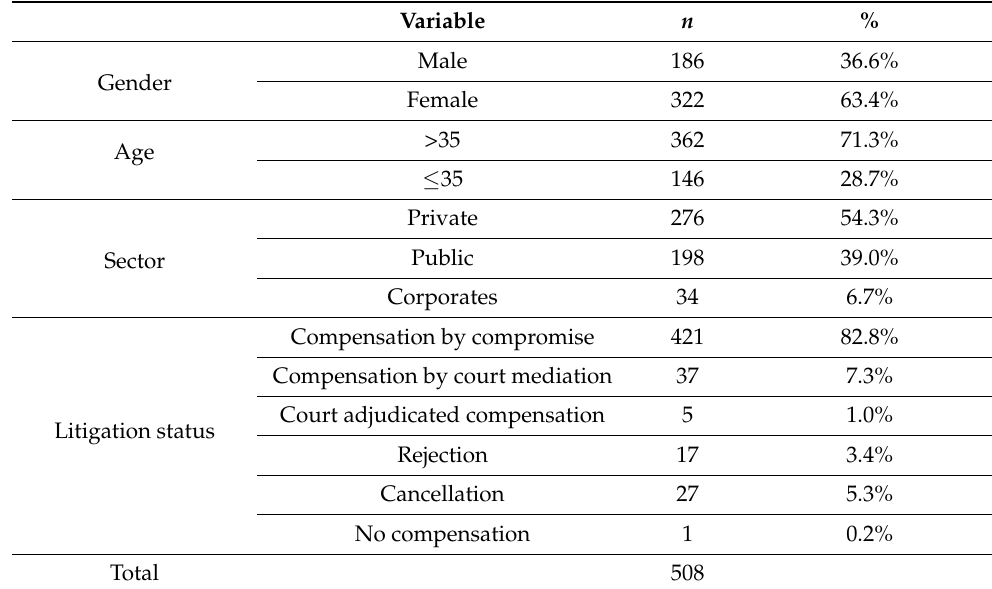
Table 1. Patient demographic characteristics.